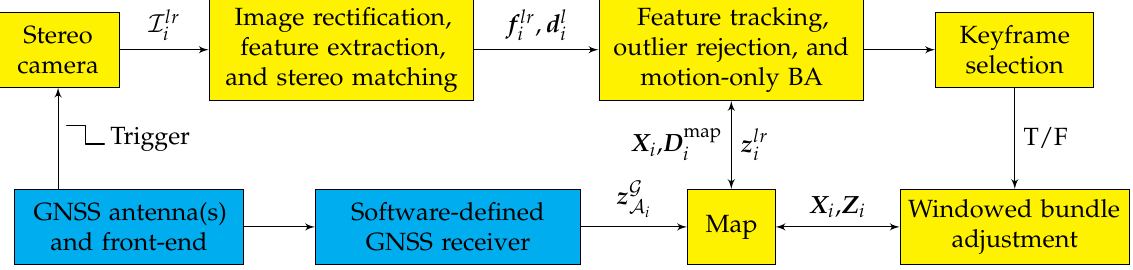
Figure 7. Globally-referenced electro-optical simultaneous localization and mapping (GEOSLAM) block diagram. BA: bundle